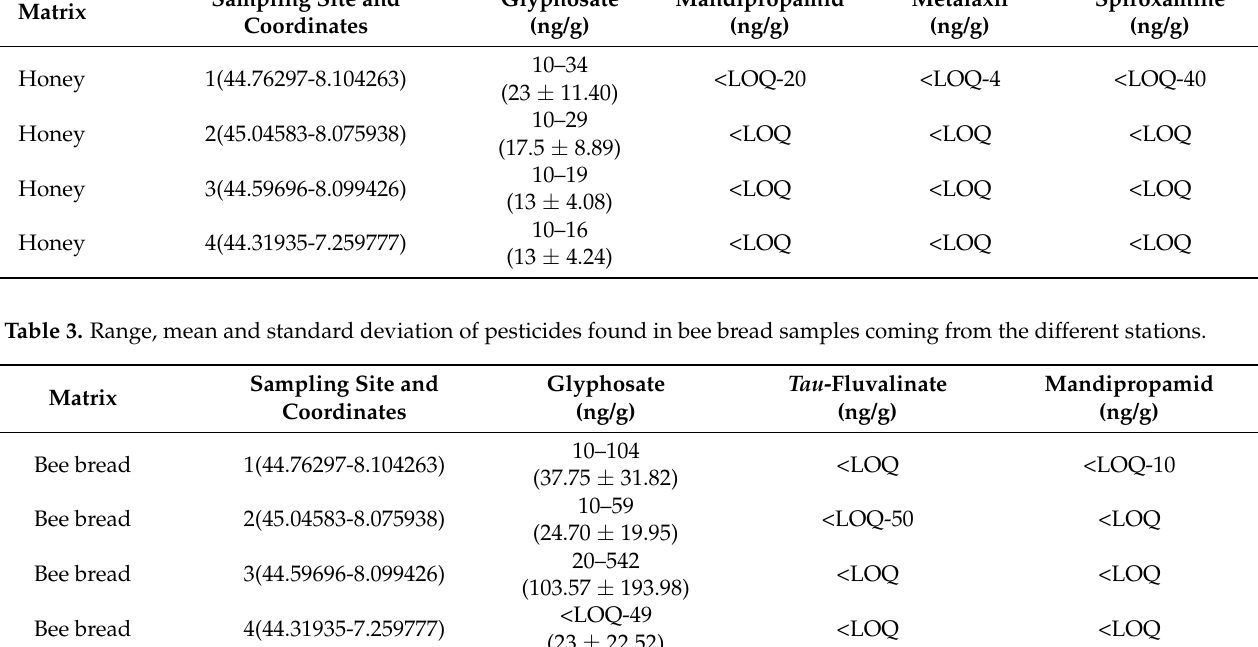
Table 2. Range, mean and standard deviation of the pesticides found in the honey samples coming from the different stations. Matrix Honey